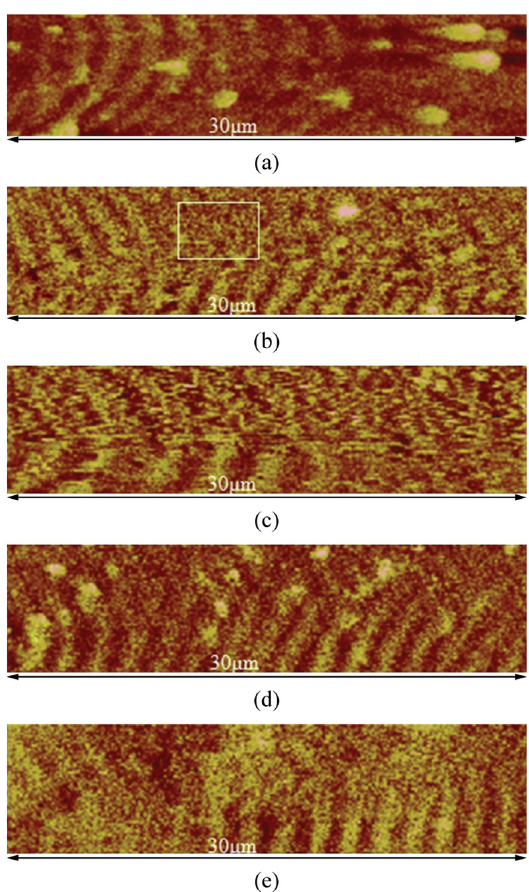
Figure 4. Magnetic domain structures of melt-extracted Co-based amorphous wires: (a) as-cast state; (b) 100 mA; (c) 200 mA; (d) 300 mA; (e) 350 mA; Ruler point is axial direction of